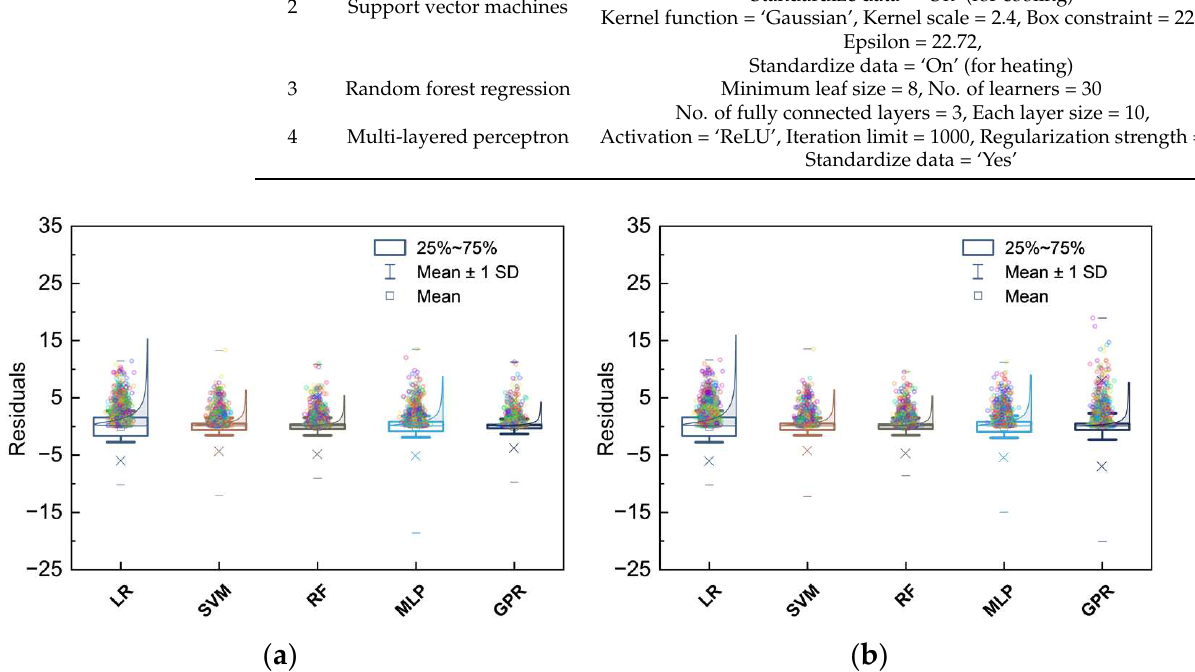
Figure 11. The comparison on the accuracy of 10-fold cross validation using linear regression and machine learning: ( a ) cooling demand; ( b ) heating demand.